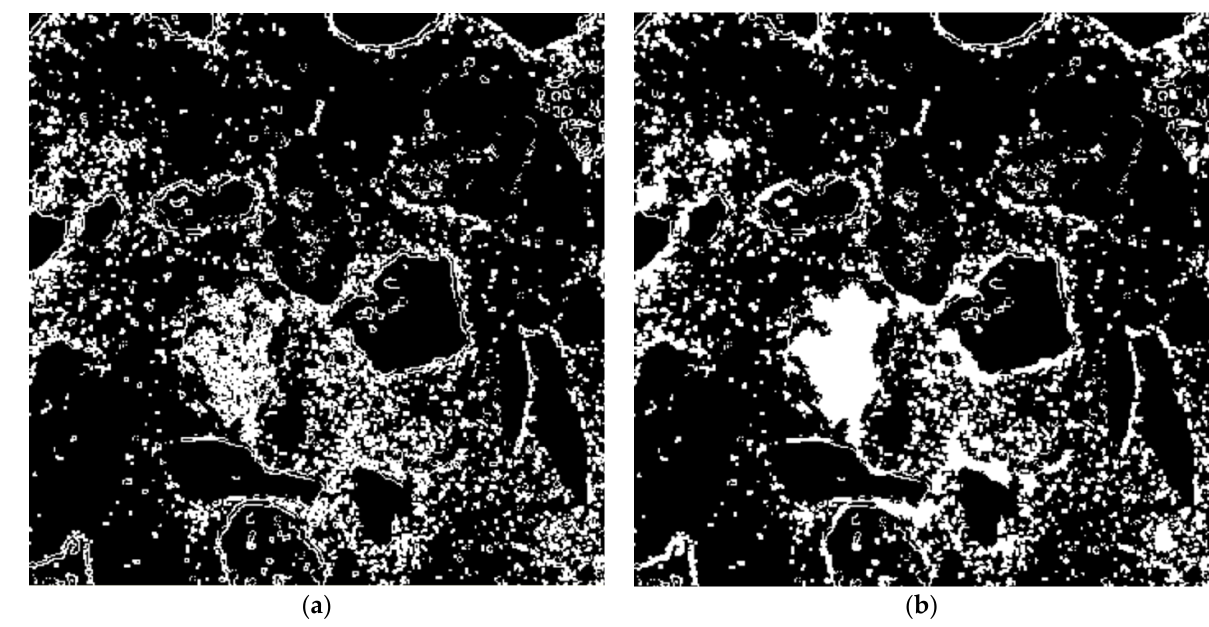
Figure 9. Processing of the results of thresholding in Figure 8: ( a ) the original thresholded map, and ( b ) the result of the fill operation. For original image see Figure 2.